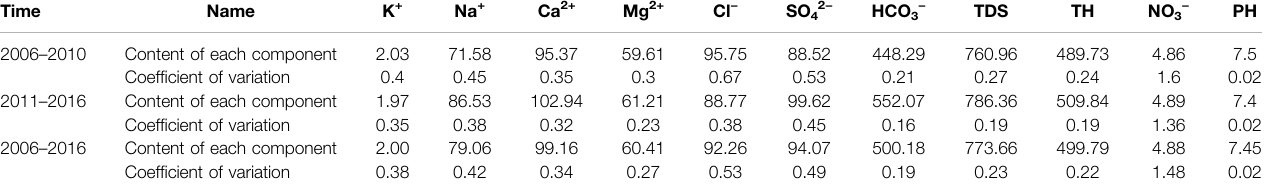
TABLE 1 | Calculation results of the chemical components and coef fi cients of variation of the shallow groundwater in the study area (unit: mg/L). Time Name